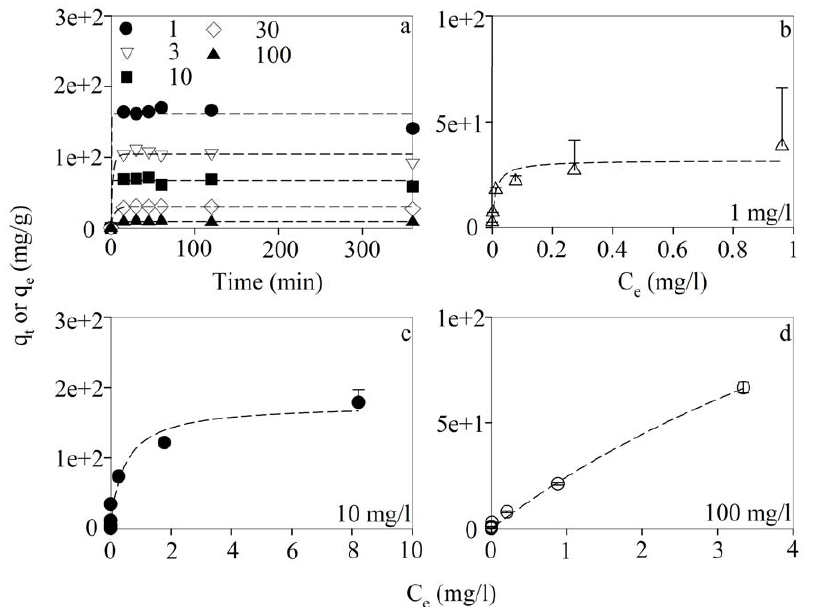
Figure 2. Adsorption of Cd 2 + (q t , mg/g) on TiO 2 -ENs in the kinetics (a) and 4-h equilibrium isotherm (b–d) experiments, respectively. There were five treatments with different concentrations of TiO 2 -ENs (1.0, 3.0, 10.0. 30.0, and 100.0 mg/l) but the same concentration of total Cd 2 + (1 mg/l) in the kinetics experiment. Various concentrations of Cd 2 + (0.003, 0.01, 0.03, 0.1, 0.3, 1.0, 3.0, and 10.0 mg/l initially) were used in each equilibrium isotherm experiment with different TiO 2 -EN concentrations (b–d: 1, 10, 100 mg/l, respectively). Since Cd 2 + adsorption got saturated when its concentration approached 0.3 mg/l with 1 mg/l TiO 2 -ENs, the two highest Cd 2 + concentrations (3.0 and 10.0 mg/l) were not used for this EN concentration treatment. Dashed lines represent the simulated curves of Cd 2 + adsorption kinetics and equilibrium isotherm by the pseudo-first order (a) and Langmuir (b–d) models. Data are mean 6 standard deviation (n=2).